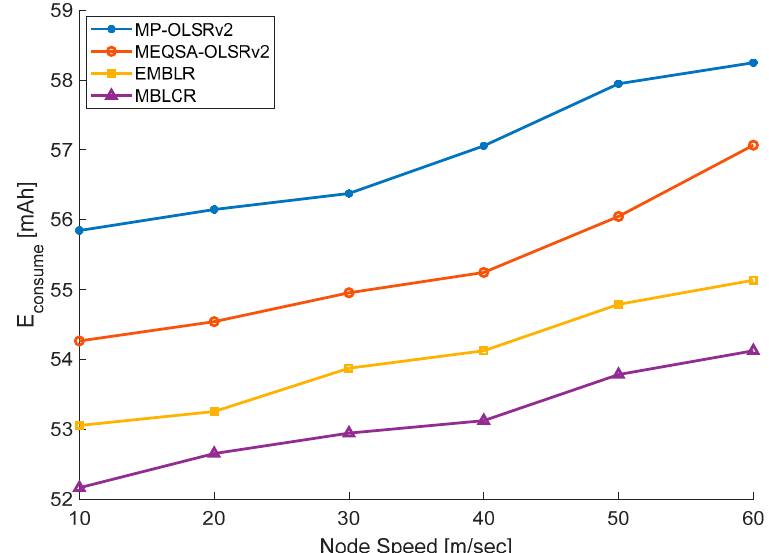
Figure 9. Energy consumption with various device speeds.